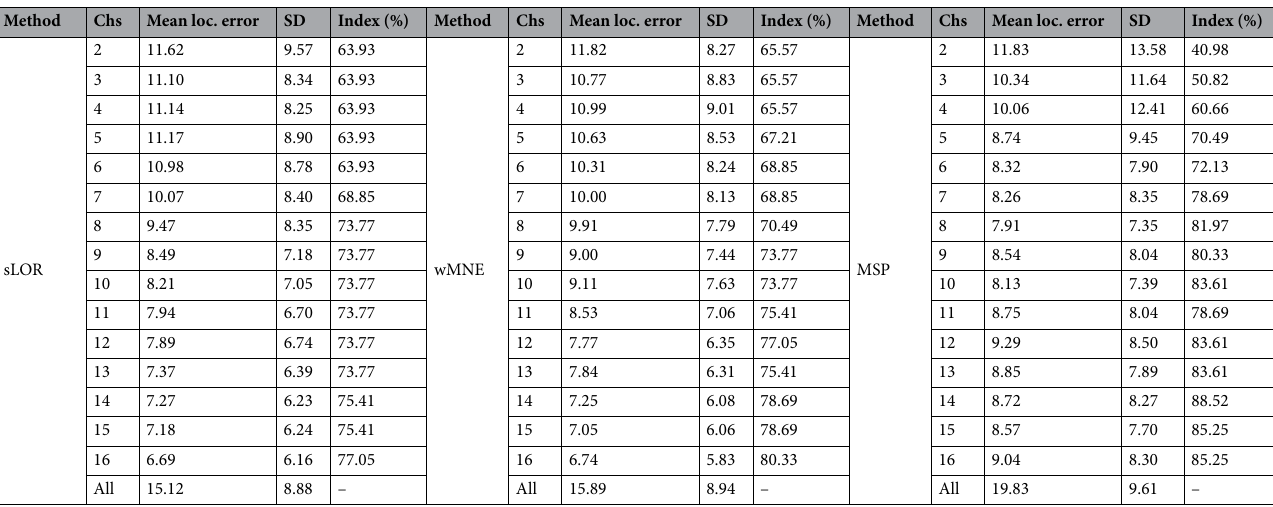
Table 3. Localize-MI test